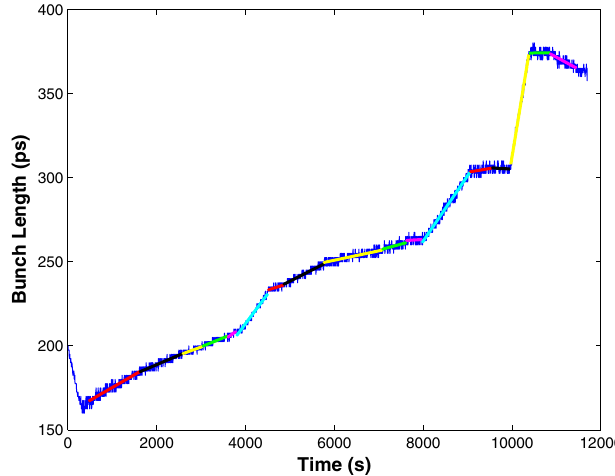
FIG. 11. Beam 2 bunch length growth. Data in blue. Linear segments correspond to different noise injection levels.